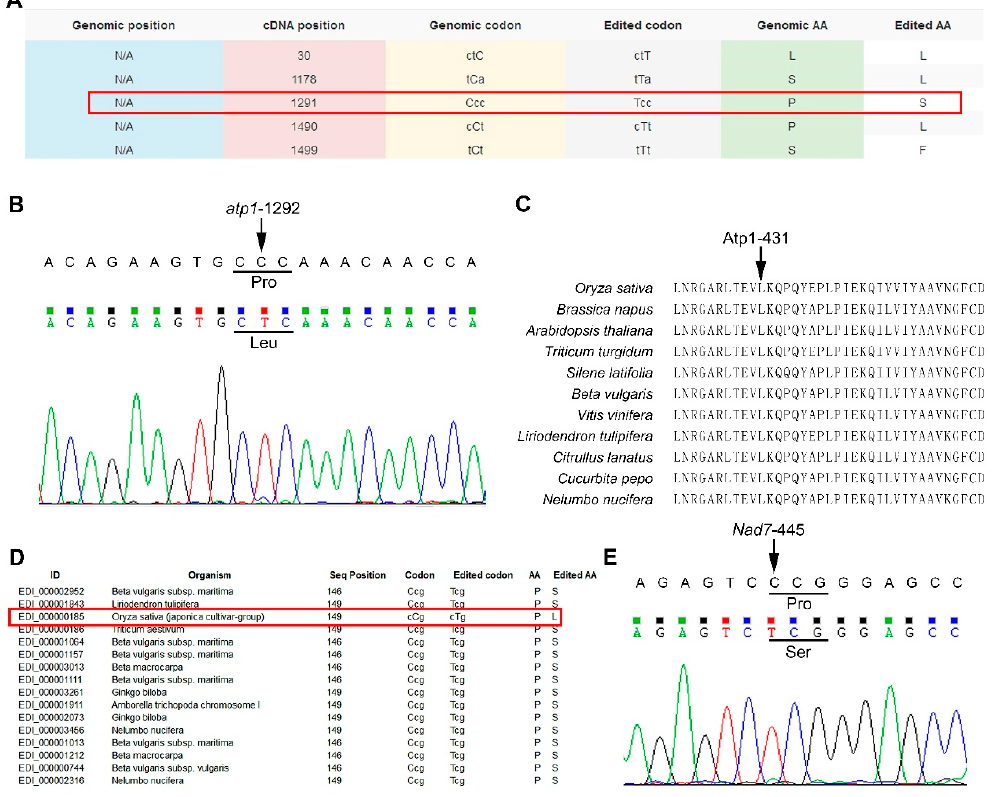
Figure 1. Confirming and correcting the annotations in REDIdb. ( A ) Annotation of RNA editing sites in atp1 transcript in REDIdb. Red box indicates the incorrectly annotated RNA editing site at atp1 -1291. ( B ) Sequence chromatogram of PCR-amplified atp1 cDNA. Arrow indicates the editing site atp1- 1292. Amino acids before and after editing are shown below the codons indicated by